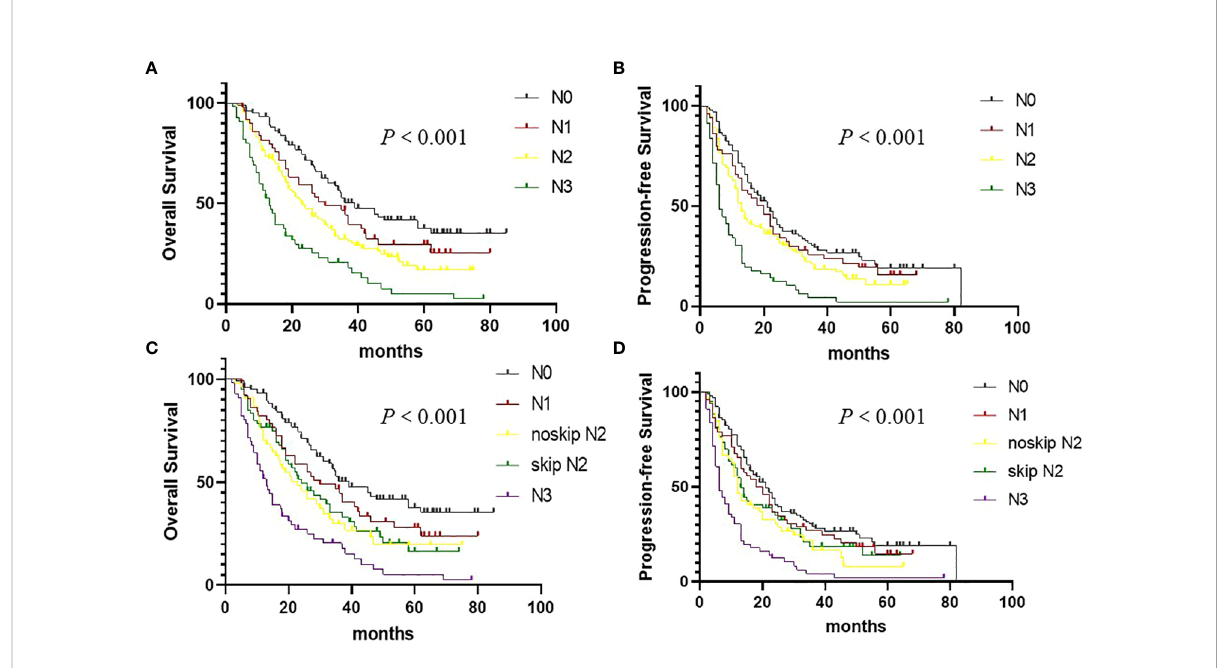
FIGURE 2 Overall survival (OS) and Progression-free survival in (PFS) non – small cell lung cancer patients according to the cN staging. (A) OS curves according to the cN staging. (B) PFS curves according to the cN staging. (C) OS curves according to the skip cN2 metastasis. (D) PFS curves according to the skip cN2 metastasis.